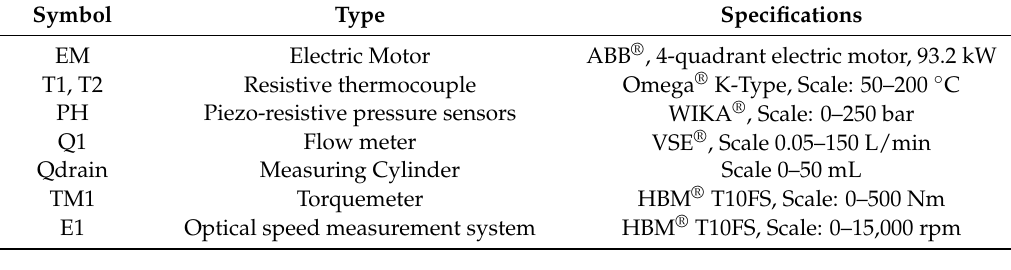
Table 1. Details of the different sensors and components used in the experimental test rig.